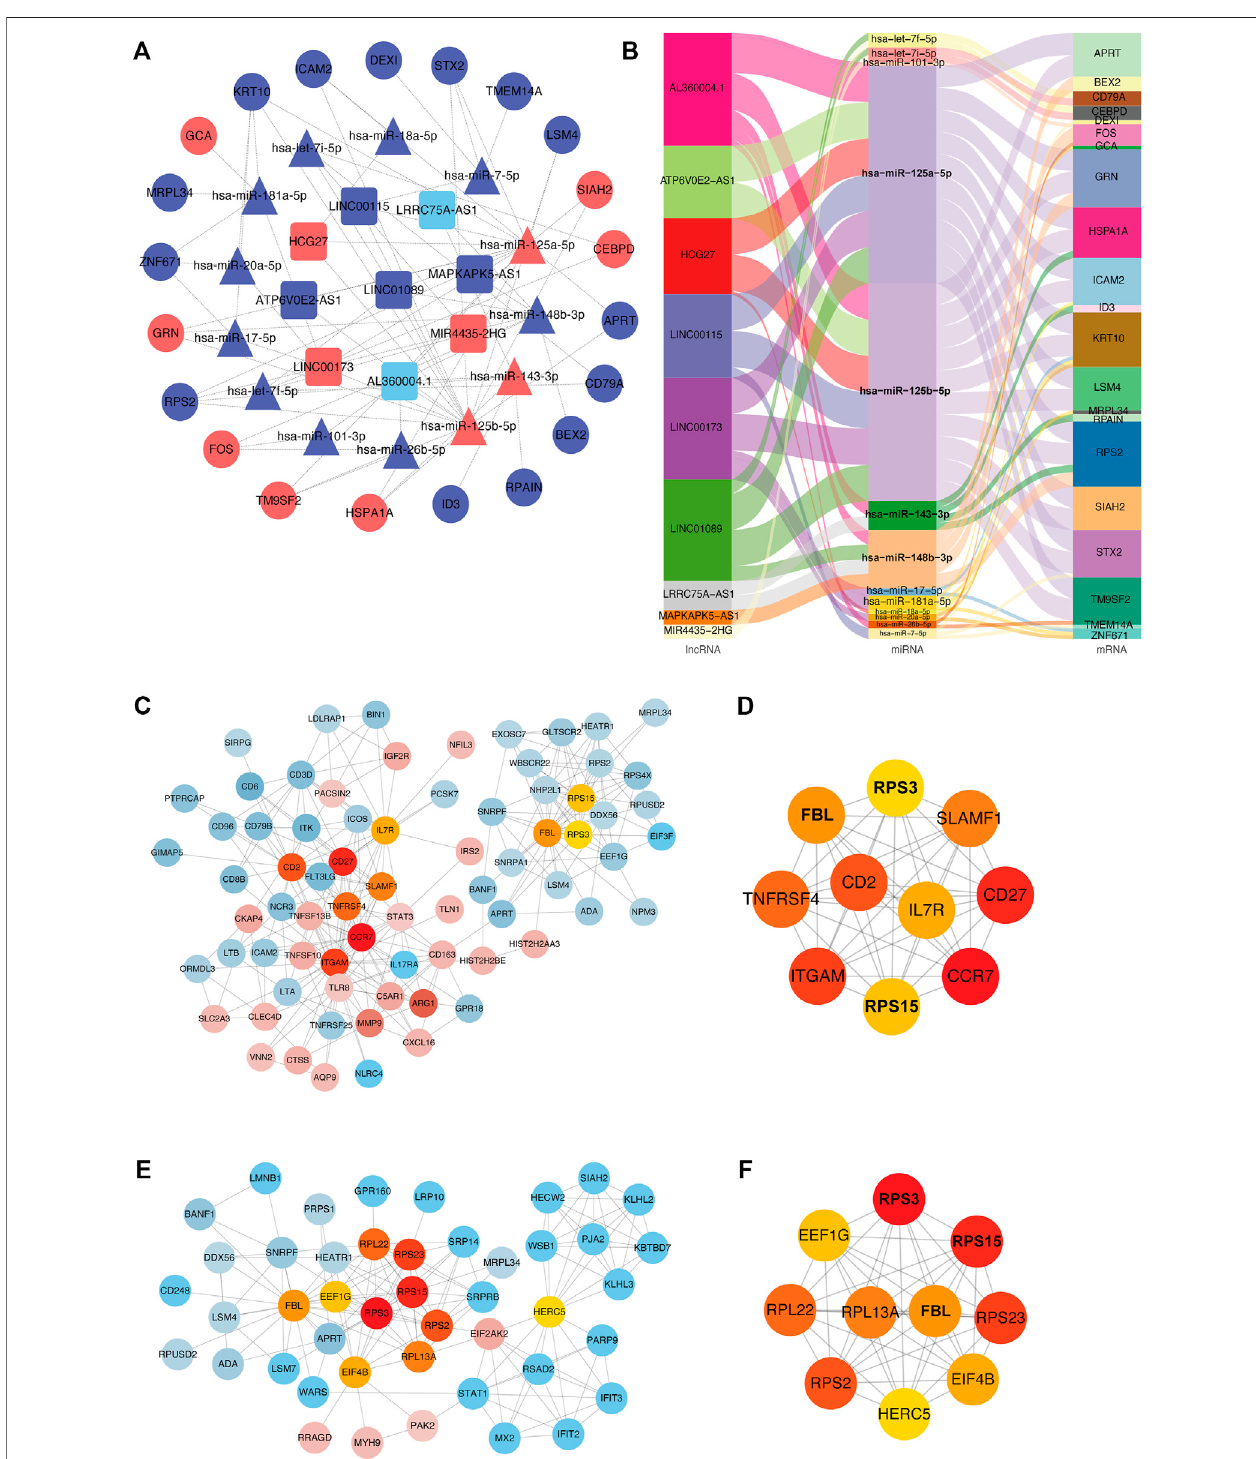
FIGURE 9 | ceRNA interaction and protein-protein interaction analysis. (A) ceRNA network diagram. In the network diagram, red indicates upregulation, blue indicates downregulation, squares indicate lncRNA, triangles indicate miRNA, and circles indicate mRNA. Sankey diagram (B) . The three columns include lncRNAs, miRNAs, and mRNAs in order from left to right. The line colors represent different types of gene-gene interactions. (C) Diagram of interaction of differentially expressed proteins. Red indicates increased expression, blue indicates decreased expression, and color intensity indicates different degrees of u-regulation or downregulation. Orange represents the hub genes. (D) Diagram of hub-genes interaction in differentially expressed proteins. (E) MiRNAs targeting mRNAs interaction diagram. Red indicates upregulated expression, blue indicates downregulated expression, and color intensity indicates different degrees of upregulation or downregulation. Orange represents hub genes. (F) Diagram of hub genes interaction in targeted mRNAs.